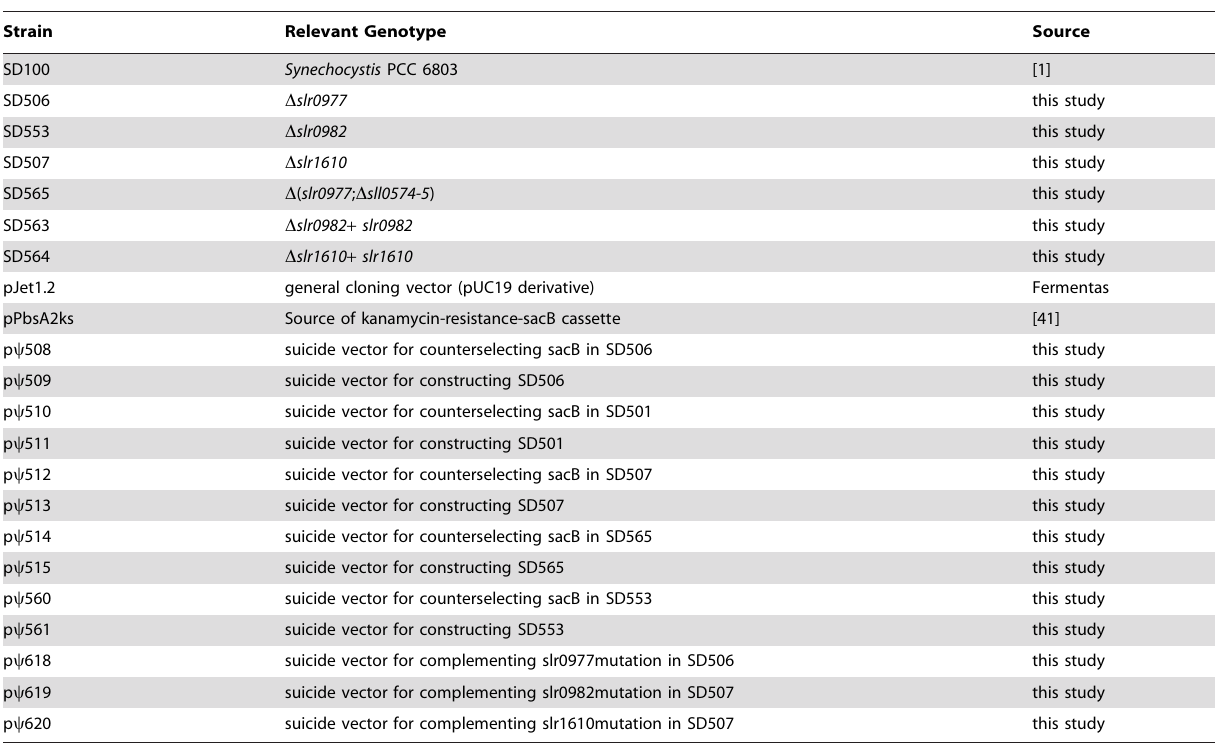
Table 3. Strains and